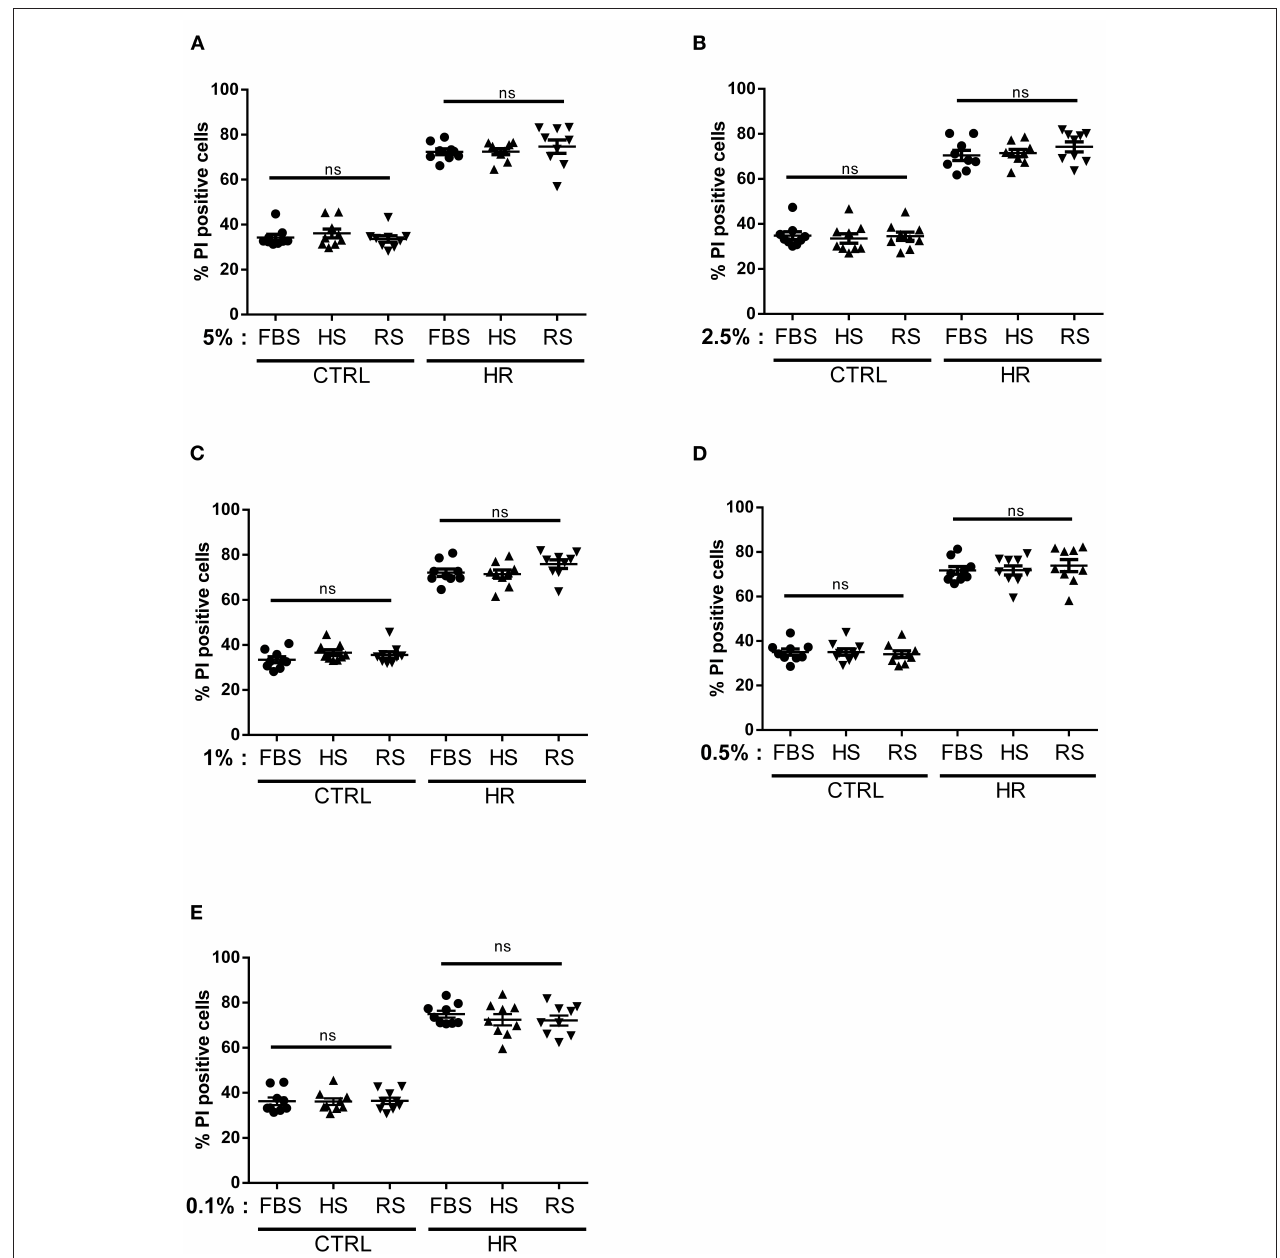
FIGURE 2 | Dose–response effects of adult serum treatment on cardiomyocyte viability: percentage of cell death measured in both normoxic (CTRL) and hypoxic (HR) cells treated with (A) 5%, (B) 2.5%, (C) 1%, (D) 0.5%, and (E) 0.1% of fetal bovine serum (FBS), horse serum (HS), and/or rabbit serum (RS). Mean of propidium iodide (PI) positive cells ± SD, n = 9 different experimental days with 1,000 events/assay. Differences in means among multiple groups were analyzed using two-way ANOVA with a Tukey’s post-hoc test (ns: non